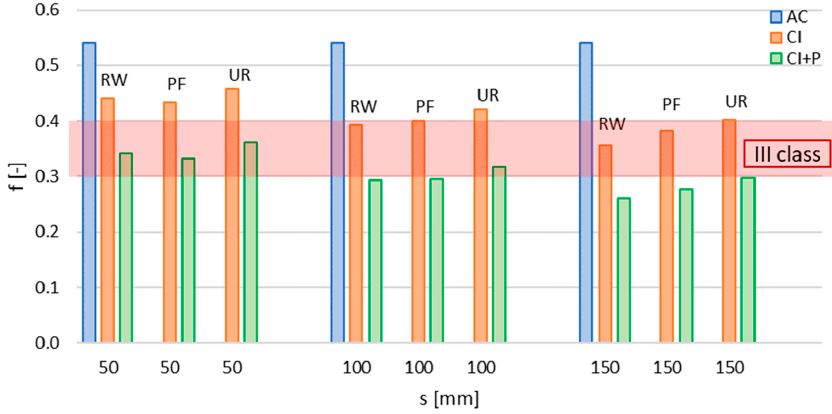
Figure 5. Decrement factor